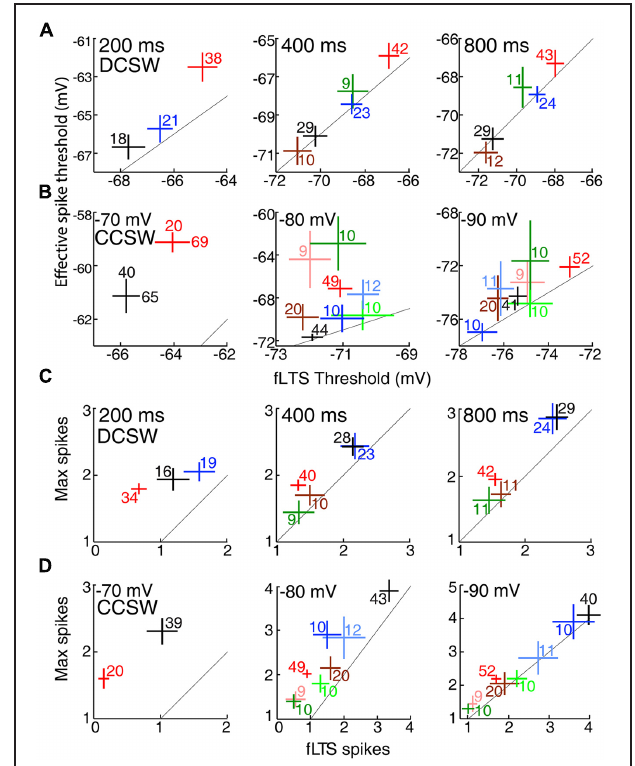
FIGURE 6 | Lower voltage thresholds and more spikes in motor than sensory thalamic nuclei. (A) Voltage thresholds (mean ± SEM) across thalamic nuclei after 200, 400, and 800 ms (left to right) at − 80 mV in the DCSW protocol. Color code as in Figure 1 . Diagonal lines indicate identity. The numbers of cells that had a LTS and thus contributed data along the x-axis are shown. The number of cells in which spikes were evoked was within ± 2 of those displaying a LTS in all nuclei under all conditions. Insufficient data was available for MGv and MD at 200 ms. (B) Same as (A) but for currents injected from − 70, − 80, and − 90 mV (left to right) in the CCSW protocol. Sufficient data at − 70 mV was available only for VL and LGN, and two inset numbers are shown because, unlike the cases of − 80 and − 90 mV, spikes could be evoked in the absence of a LTS in many neurons and thus we were able to measure effective spike threshold in a larger number of neurons than fLTS threshold. (C) Spike counts (mean ± SEM) after 200, 400, and 800 ms (left to right) in the DCSW protocol, evoked by the fLTS and in response to the current that caused the maximum spike count (usually but not always the largest current tested). Cells with no LTS were excluded from each measure of spike count. (D) Same as (C) but showing CCSW data.